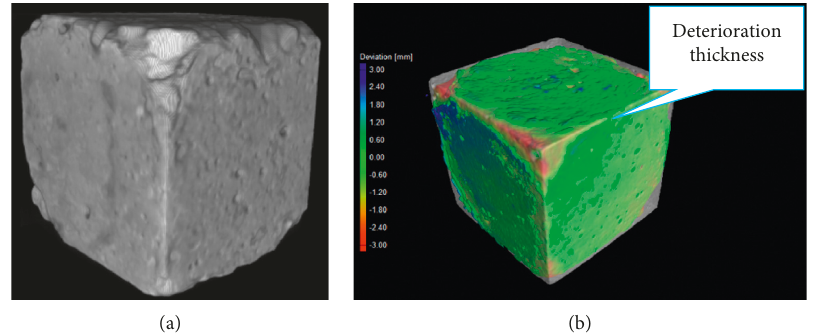
Figure 19: The deterioration thickness of concrete specimen (63 days). (a) Deterioration surface and (b) deterioration thickness.